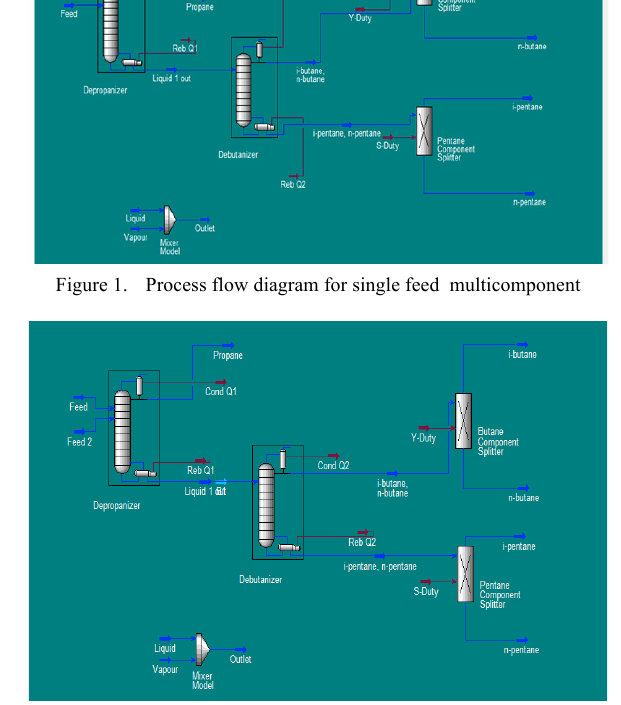
Figure 2. process flow diagram for splitted feed multicomponent system.